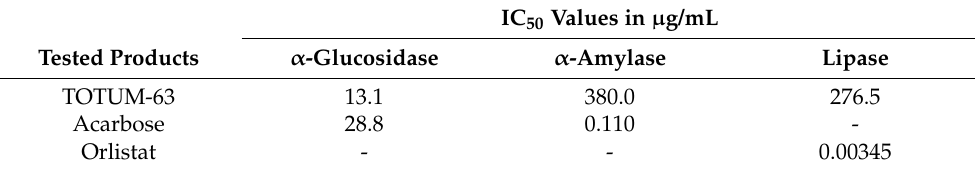
Figure 1. Inhibition of an α -glucosidase by TOTUM-63 ( a ) and acarbose ( b ) of an α -amylase by TOTUM-63 ( c ) and acarbose ( d ), and of a lipase by TOTUM-63 ( e ) and orlistat ( f ). Values are the mean ± SEM (the error bars represent the SEM with n = 2–9 and the SEM values were <10% of the mean values for acarbose or orlistat and <16% of the mean values for TOTUM-63). Table 1. IC 50 of TOTUM-63 and reference drugs for α -glucosidase, α -amylase, and lipase